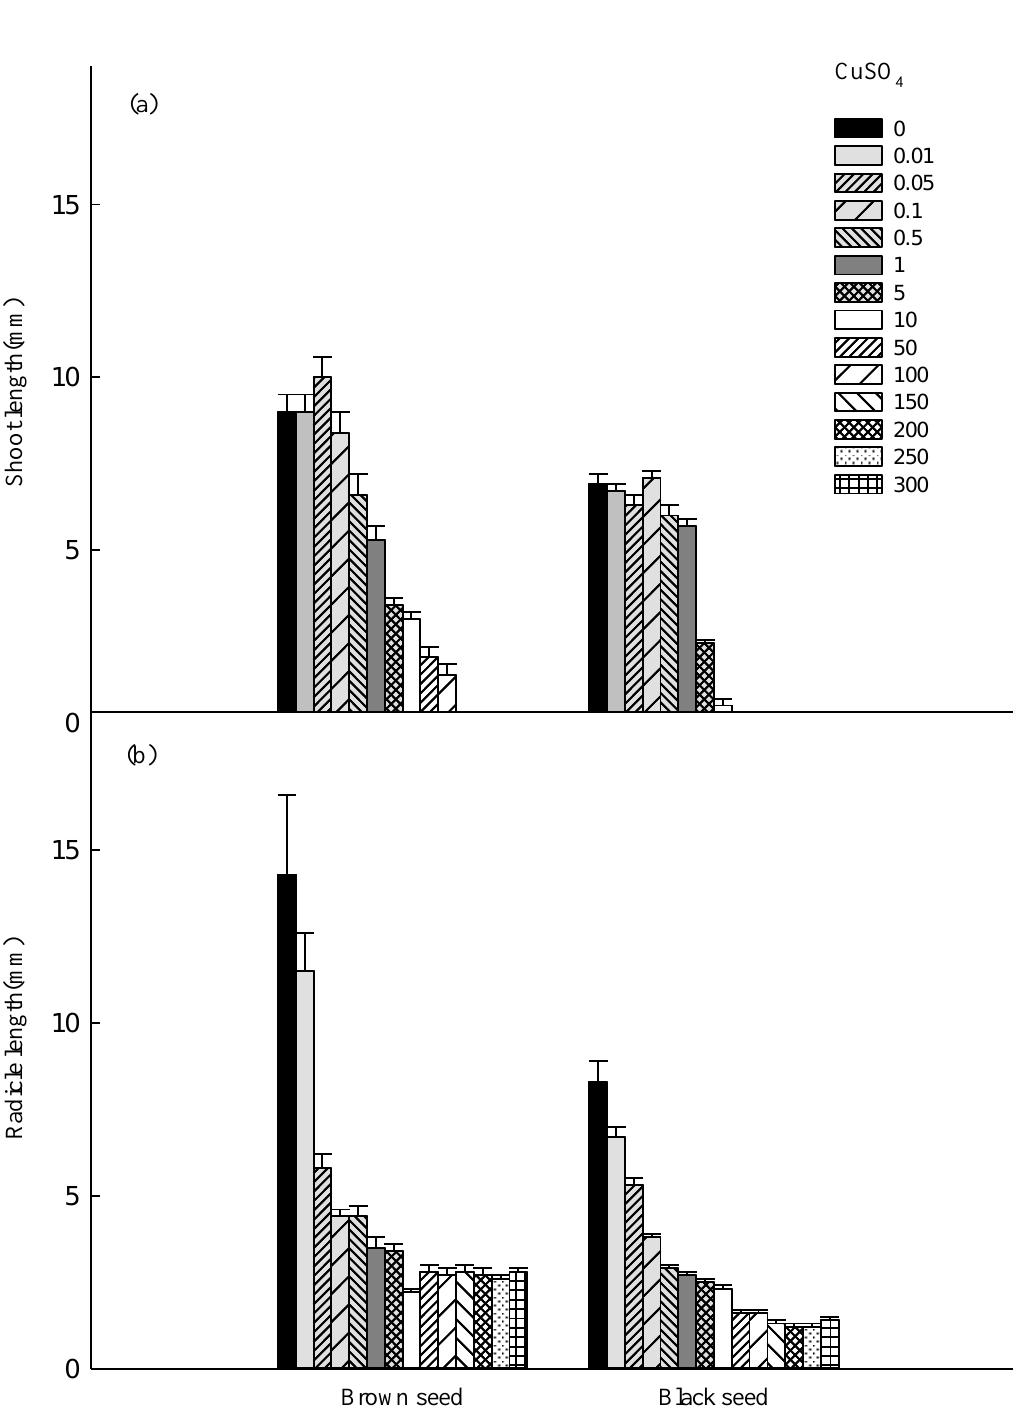
Figure 1. Effect of Cu on ( a ) shoot and ( b ) radicle length of seedlings grown from dimorphic seeds of S. salsa .